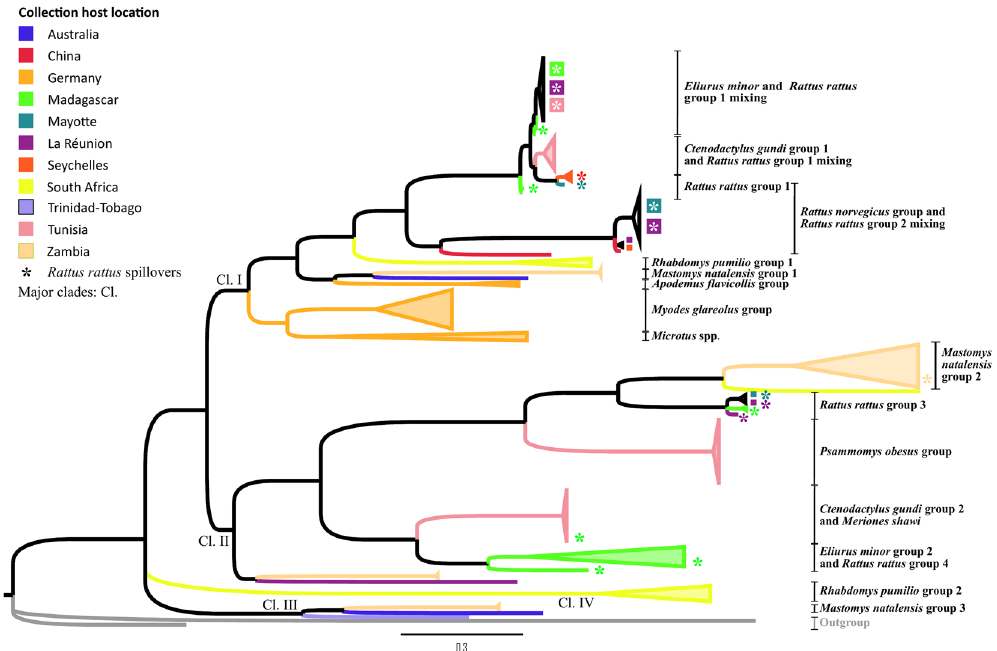
Figure 1. Bayesian phylogeny of the partial L - gene of Rodentia associated UMRV infecting Tunisian rodents and associated GenBank accession numbers. The branches are colored based on the sequence geographic origin as delineated in the figure key. Groups are identified according to the host UMRV species. Viruses preceded by an asterisk indicate a spillover event between Rattus rattus and other Rodentia species. Virus designations are as follows: Virus name or virus affiliation/host/Genbank accession number/country of origin/collection year/ host family. Abbreviations are detailed in Supplementary Data S4. Two Respirovirus sequences (HQ660195 and AB844426) form the